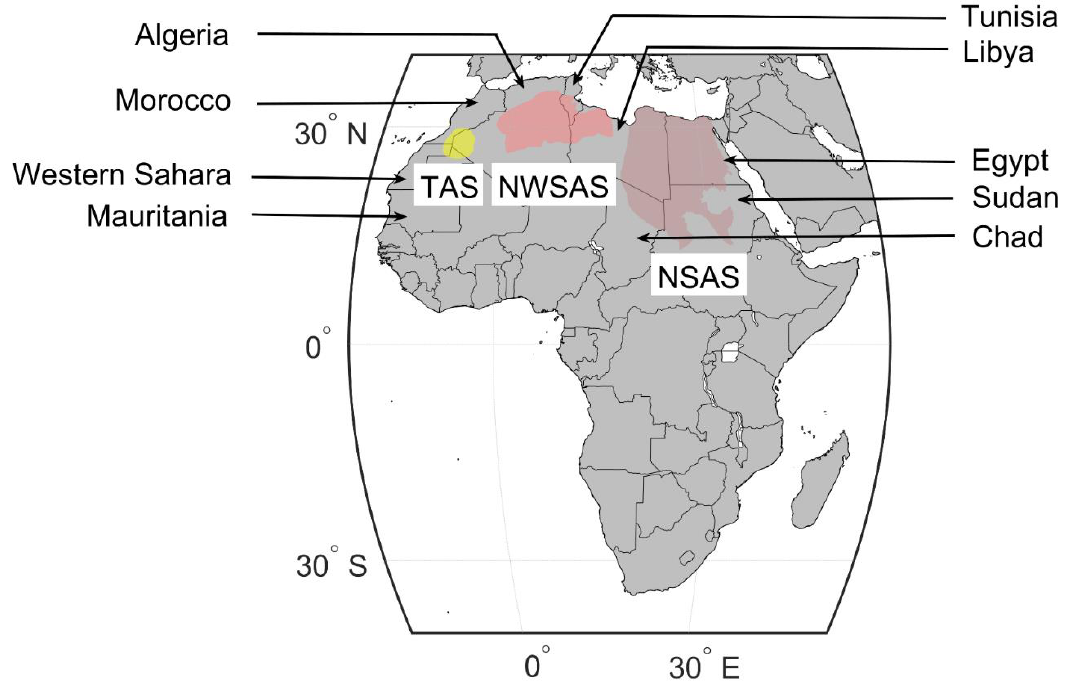
Figure 1. Location of the Tindouf Aquifer System (TAS), of the North Western Sahara Aquifer System (NWSAS) and of the Nubian Sandstone Aquifer System (NSAS) in Africa. TBA boundaries were provided by [36]. In this database, the area of these TBA are 221,019, 1,279,963 and 2,892,867 km² for TAS, NWSAS, and NSAS respectively.